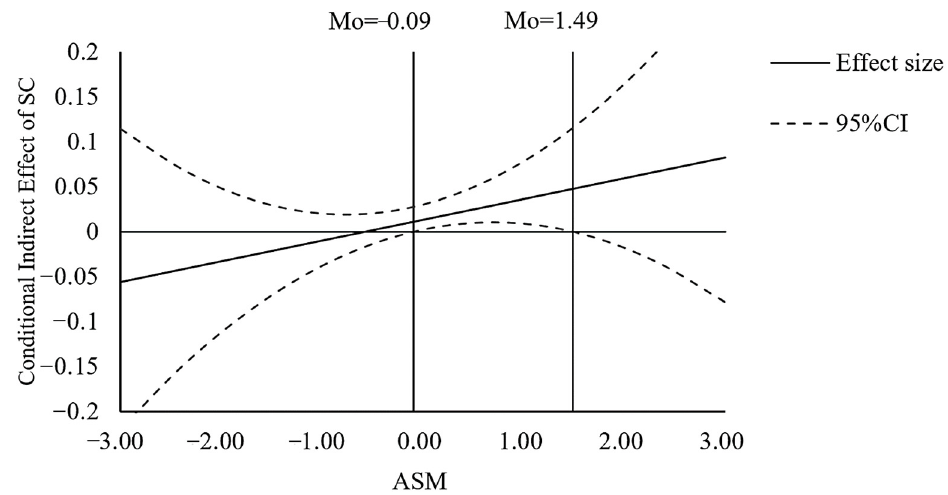
Figure 5. The indirect effect of Income on Happiness via Sense of Control (SC) versus Ability to Savor the Moment (ASM), with confidence bands in study 2.